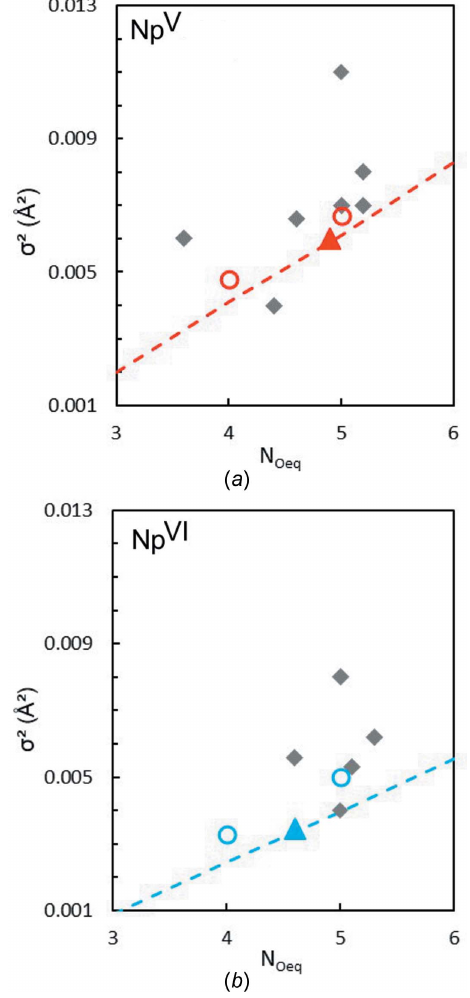
Figure 5 (cid:4) 2 N plots from the Np VI and Np V fits. Blue and red dashed lines are the (cid:4) 2 variation as a function of N Oeq for Np VI and Np V , respectively. Previous reported single-point fit values are given as grey diamonds (Antonio et al. , 2001; Ikeda-Ohno et al. , 2008, 2009; Hennig et al. , 2009; Di Giandomenico et al. , 2009; Combes et al. , 1992; Allen et al. , 1997; Reich et al. , 2000; Scheinost et al. , 2016; Denecke et al. , 2005). The open circles are DFT- calculated